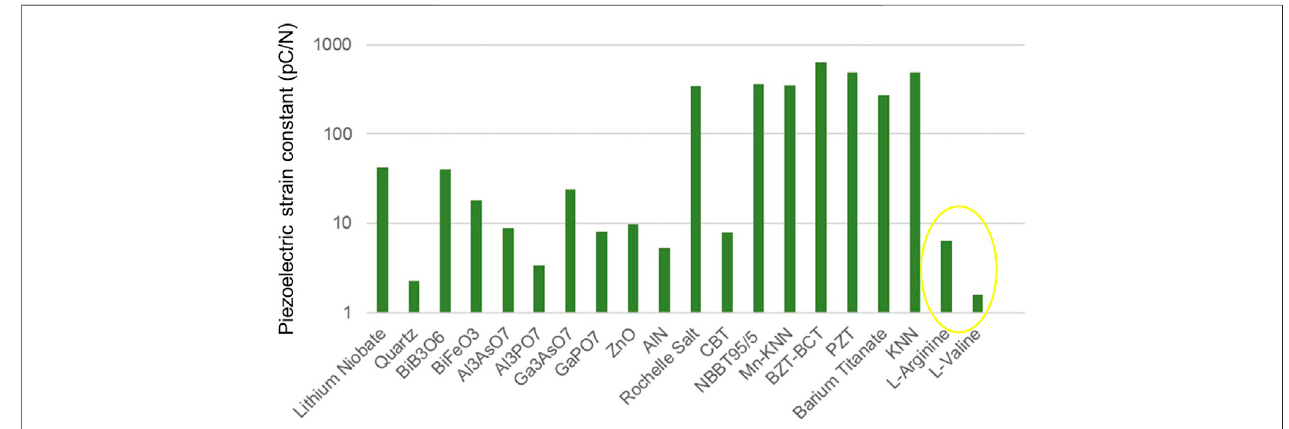
FIGURE 2 | Graph placing the piezoelectric charge constants of L-Arginine and L-Valine (circled in yellow) in the context of common inorganic single crystals and ceramics c).